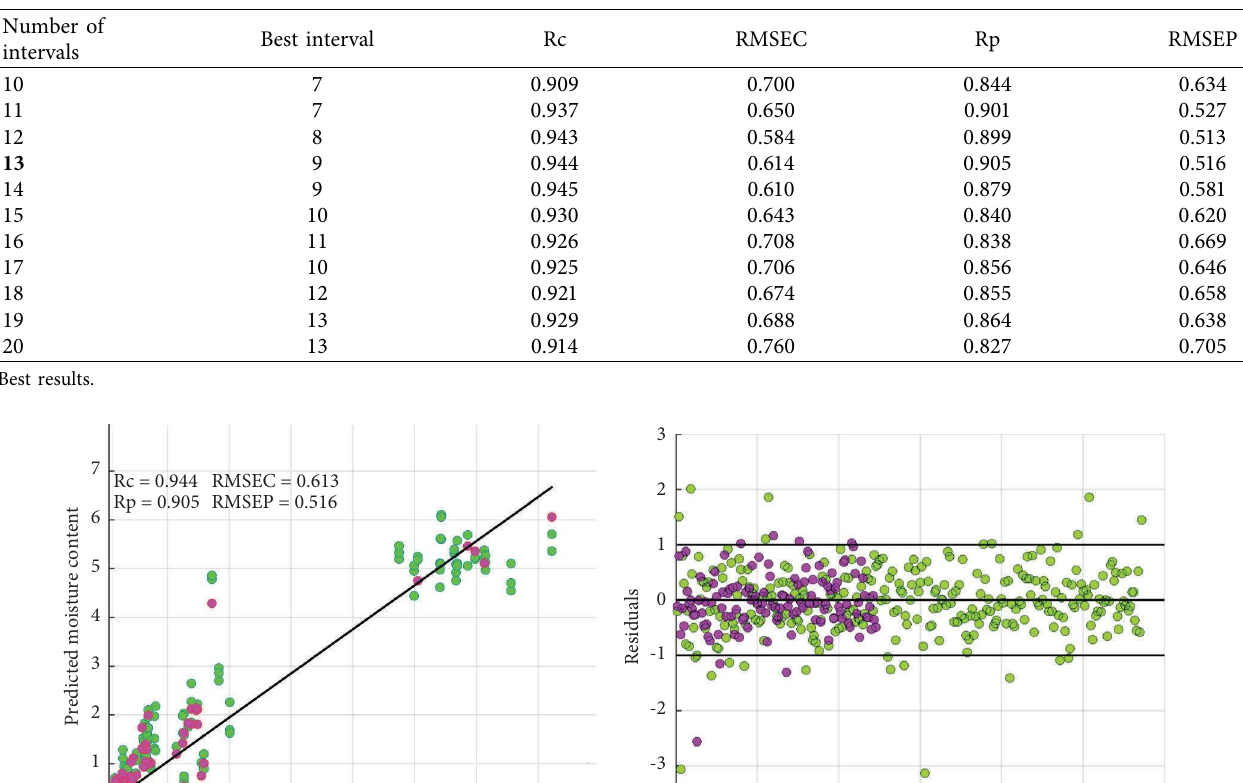
Table 3: SGD1-iPLS result for diferent numbers of intervals.